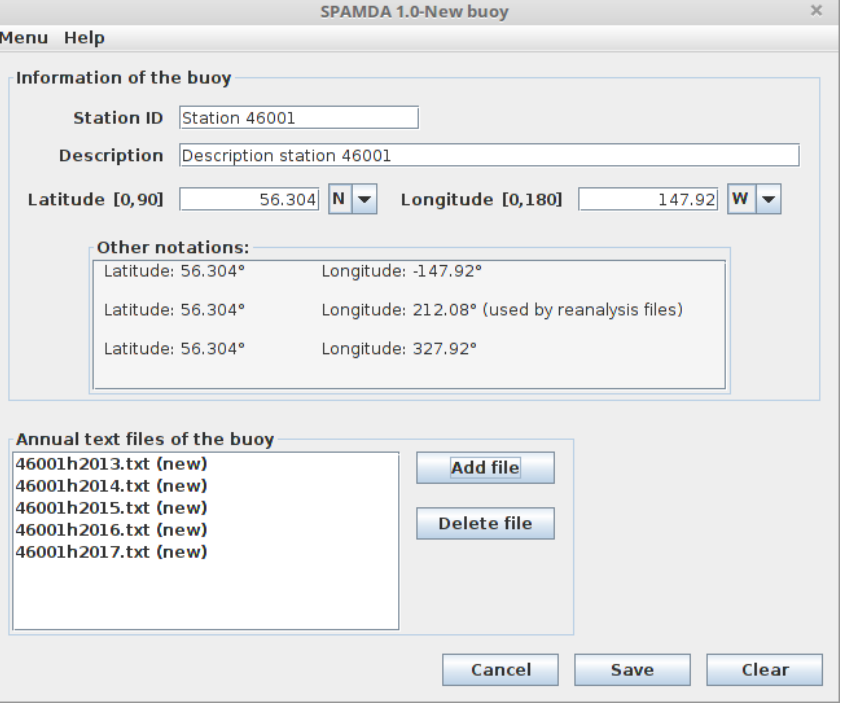
Figure 15. New buoy view: information of the buoy ID